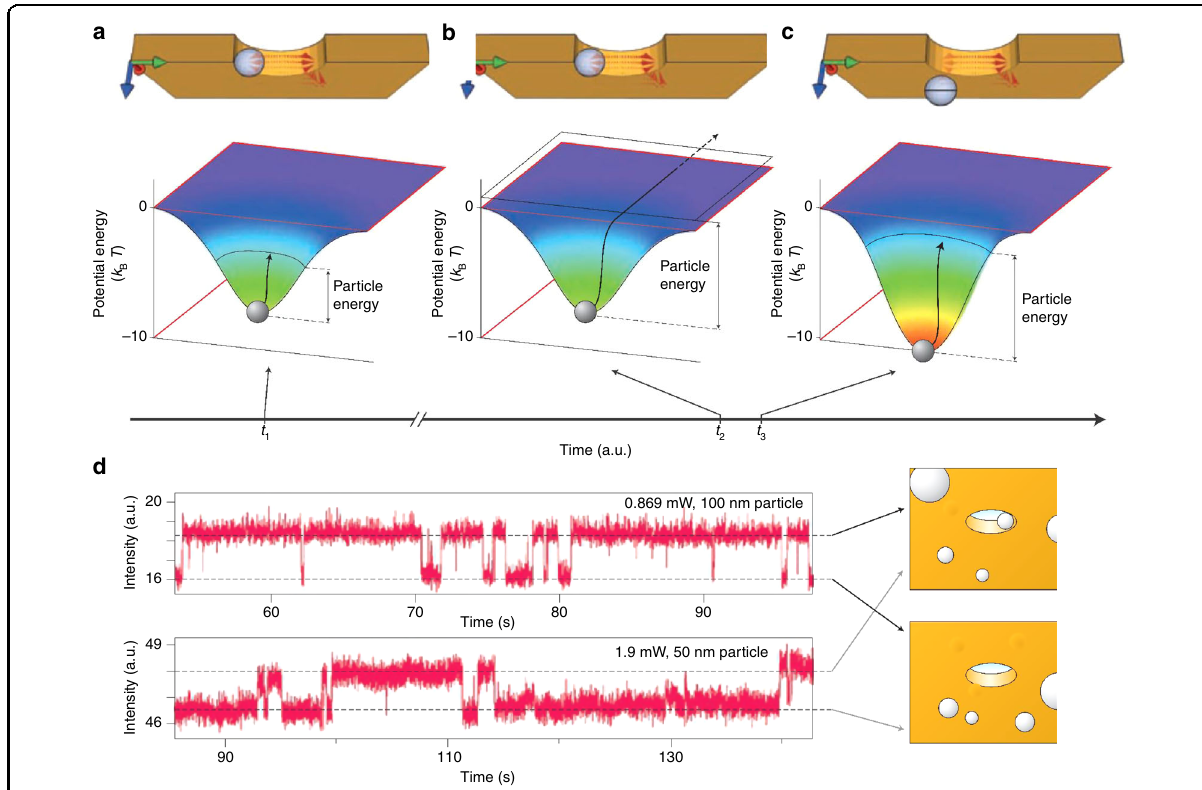
Fig. 4 Self-induced back-action-assisted trapping. a – c SIBA optical trapping with a nanoaperture in a metallic fi lm. d Time trace of the transmission intensity in plasmonic trapping of 100- and 50-nm polystyrene beads in a 310-nm aperture drilled in a gold fi lm. Reproduced with permission from ref. 20 , Copyright 2011, Macmillan Publishers